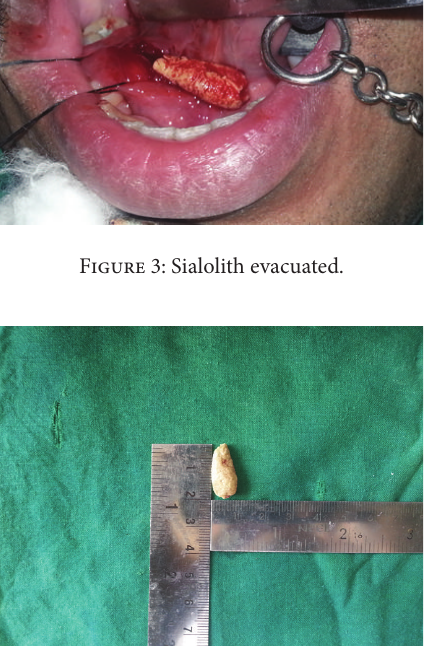
Figure 4: Sialolith measuring 20